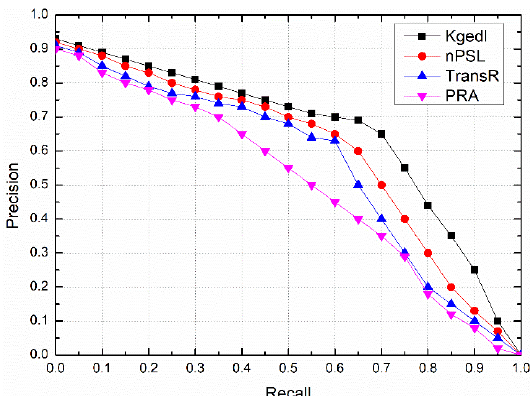
Figure 2. The recall rate precision comparison results between Kgedl and baseline methods on the YAGO dataset.